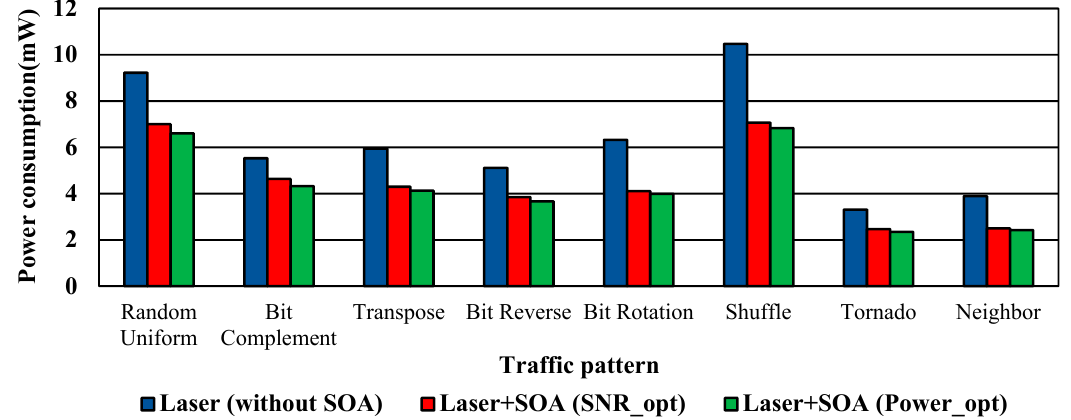
Figure 16. Power consumption comparison between a conventional HONoC (without SOA) and SOA-enabled HONoC optimized for SNR and power consumption, respectively, for various traffic patterns.